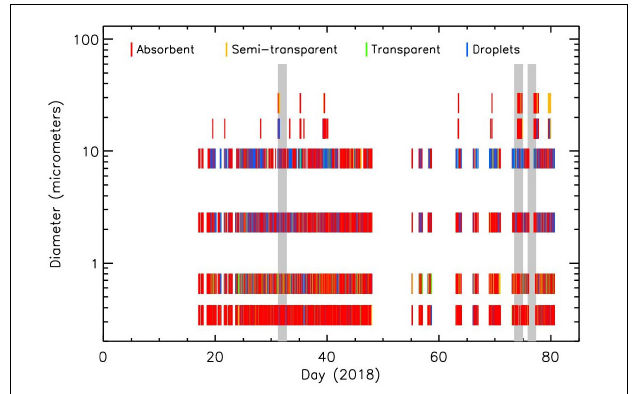
FIGURE 4 | The LOAC typology measurements; the three events are indicated by gray zones.